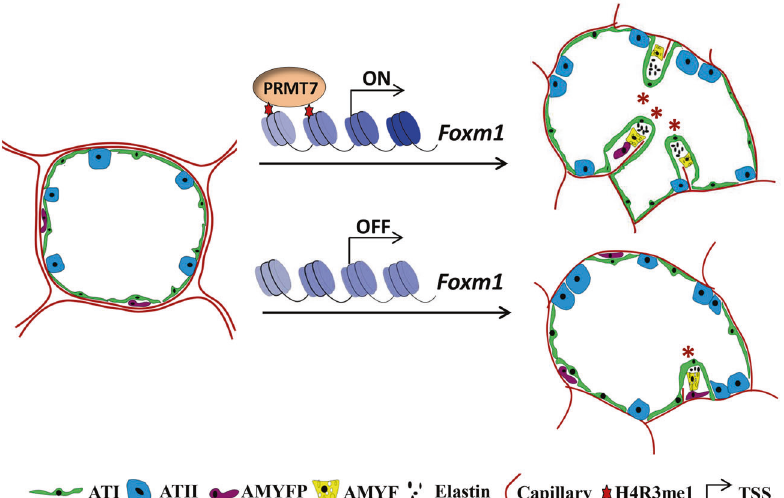
Fig. 8 A proposed working model of PRMT7 during lung alveolarization. During lung alveolar morphogenesis, PRMT7 and H4R3me1 directly bind to the promoter of Foxm1 to activate its expression, and thereby promote the proliferation and differentiation of AMYFs. In the absence of PRMT7 and H4R3me1, repressed Foxm1 results in reduced proliferation and differentiation of AMYFs, compromised elastin deposition, failure of septa formation, and eventually form a lung with enlarged distal airspaces structures. The red star indicates the secondary